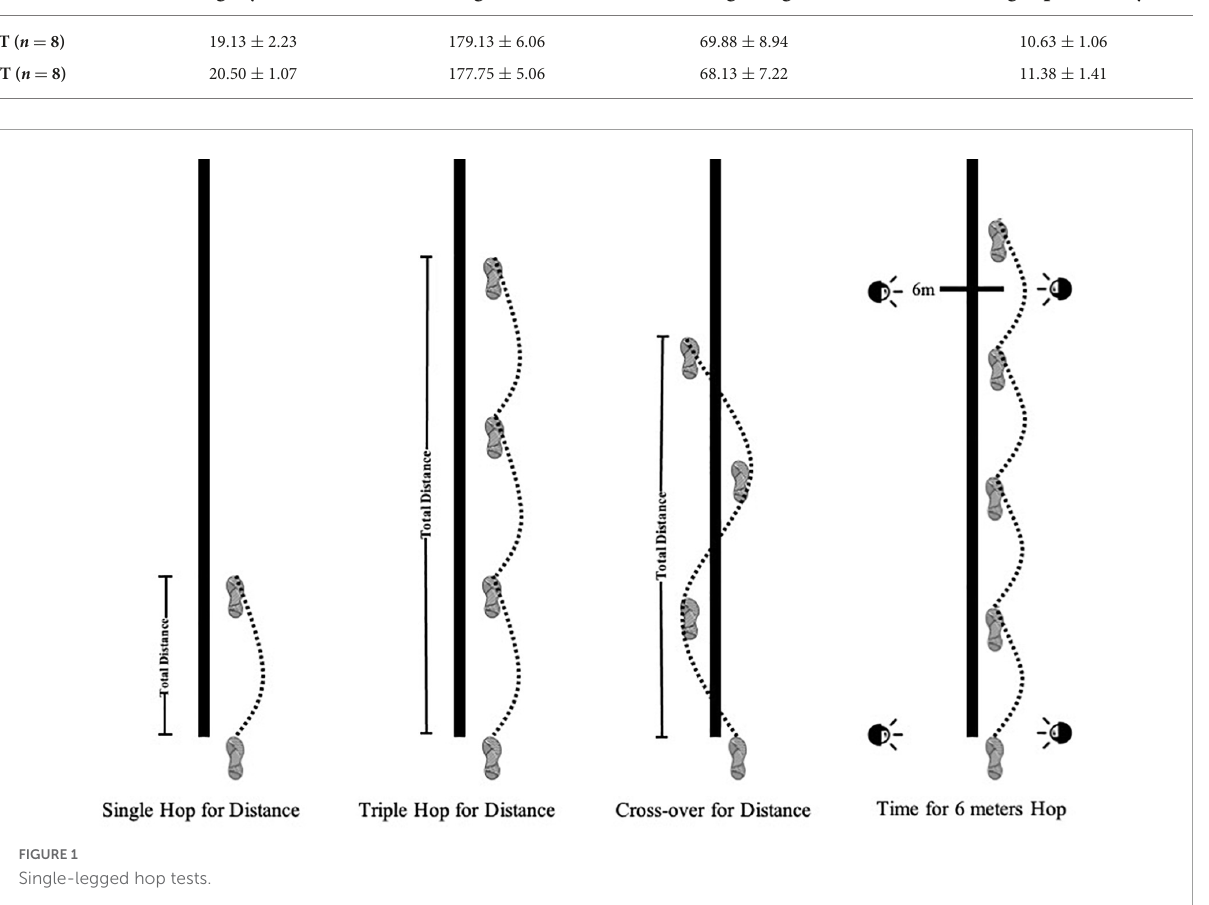
FIGURE1 Single-legged hop